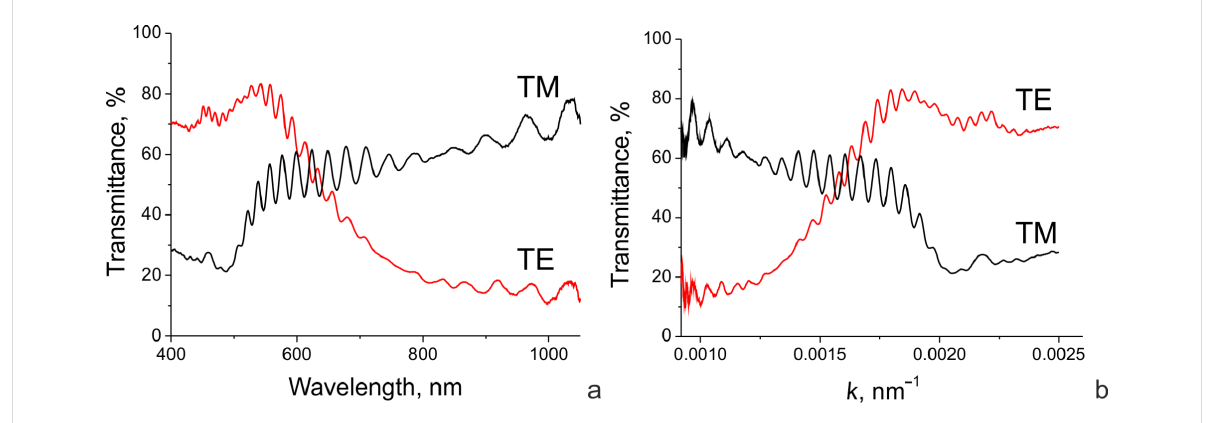
Figure 4: The transmittance for the grating with p = 300 nm and w / p = 1/2 versus wavelength (a) and wavenumber (b).